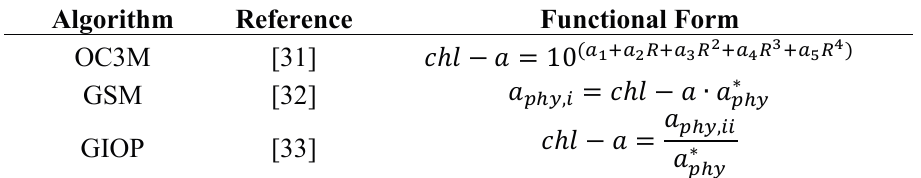
Table 1. Functional form of MODIS chl- a algorithms. OC3M, ocean color 3-band ratio; GSM, Garver-Siegel-Maritorena; GIOP, generalized inherent optical